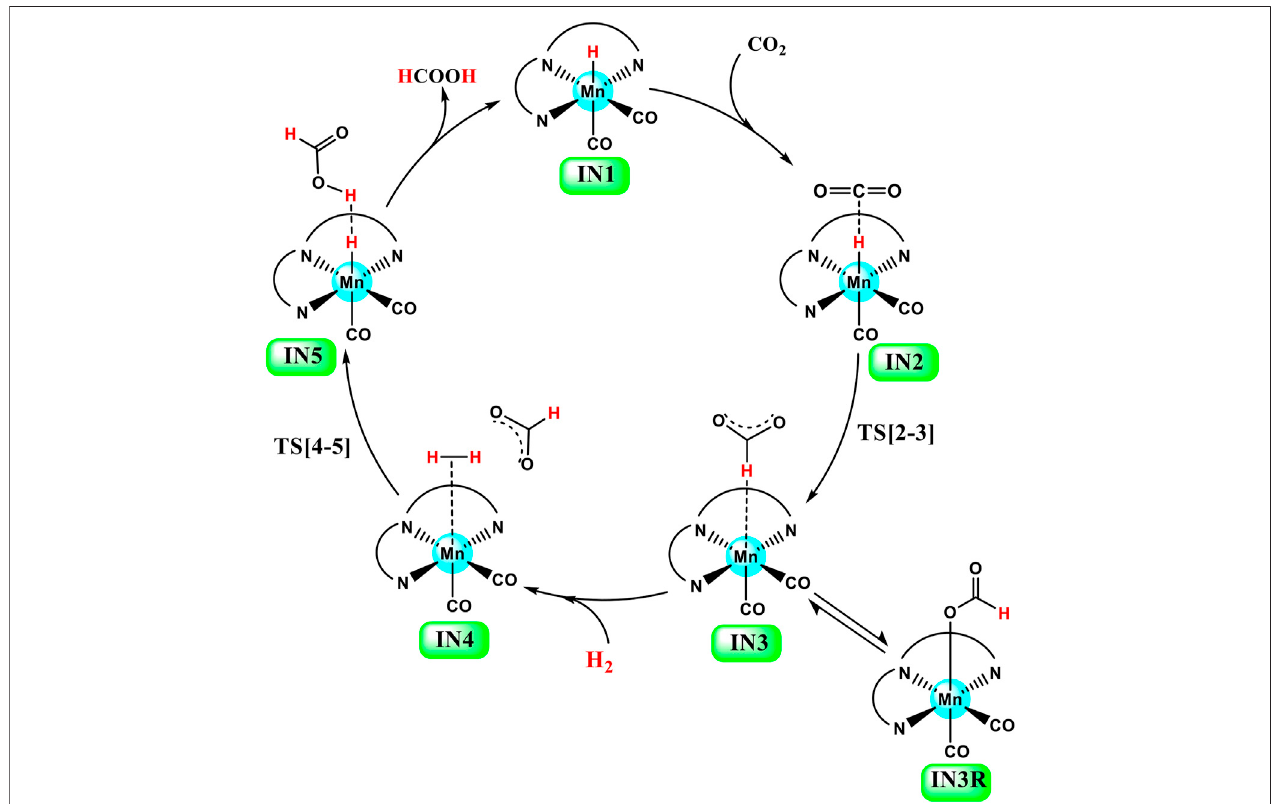
FIGURE3| GeneralcatalyticcycleofMn(I)NNN-catalyzedhydrogenationofcarbondioxidetoformicacidthroughtheNCpathwayfor Groups1 , 2 ,and 3 catalysts.